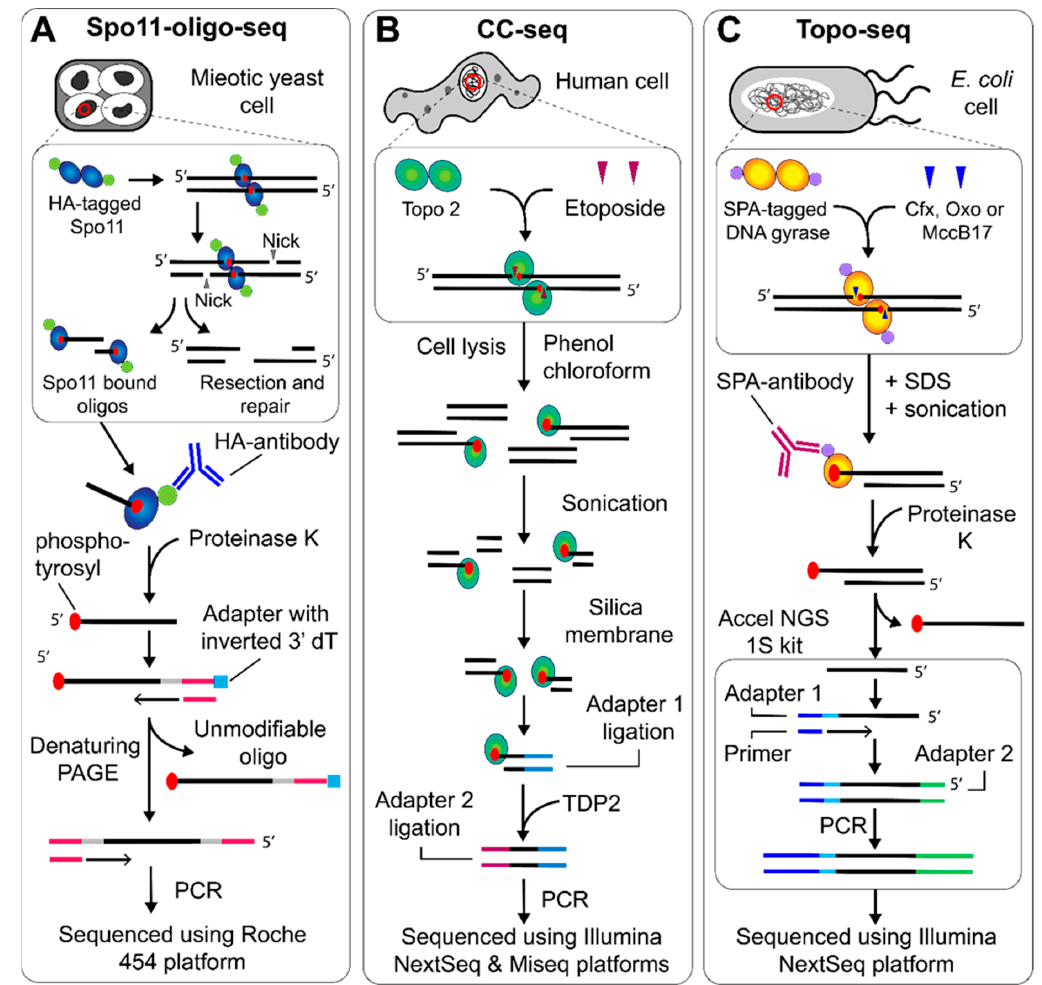
Figure 2. NGS protocols to map topo cleavage sites genome wide. ( A ) Spo11-oligo-seq began with DNA extraction from meiotic S. cerevisiae cells. HA-tagged Spo11-bound DNA oligos are enriched